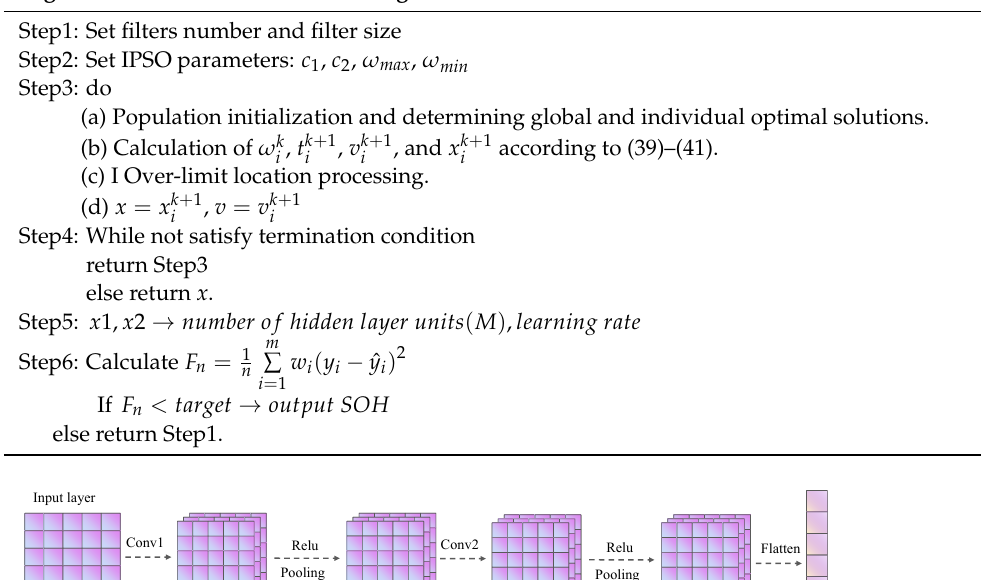
Algorithm 1. IPSO-CNN-BiLSTM Algorithm